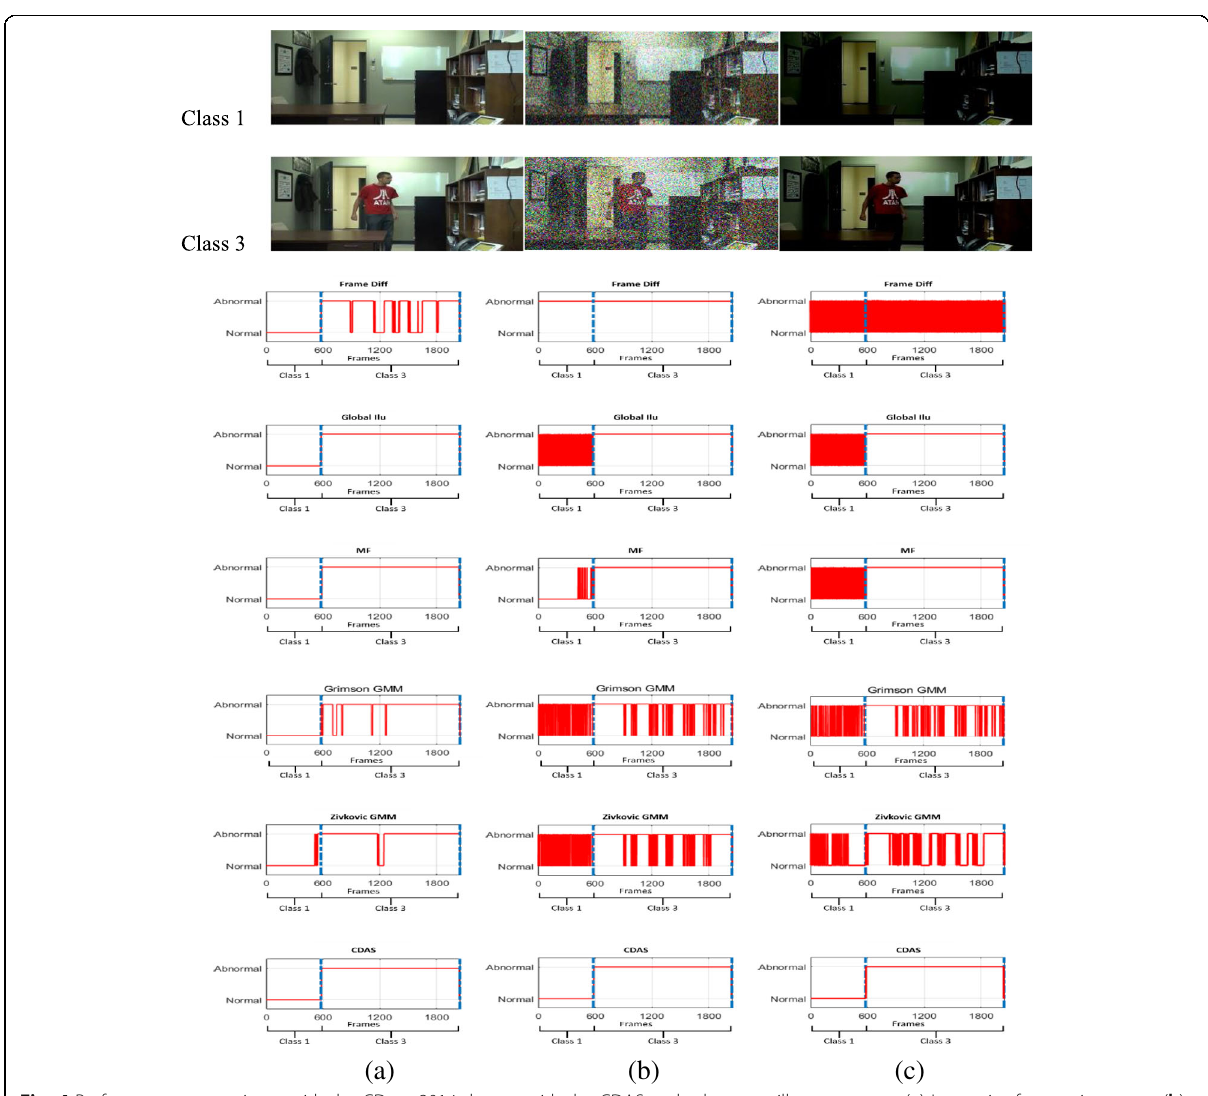
Fig. 4 Performance comparisons with the CDnet-2014 dataset with the CDAS and other surveillance systems. ( a ) In a noise-free environment. ( b ) In the presence of noise. ( c ) When the brightness changes, the pictures on the top are sample images of an “ office ”